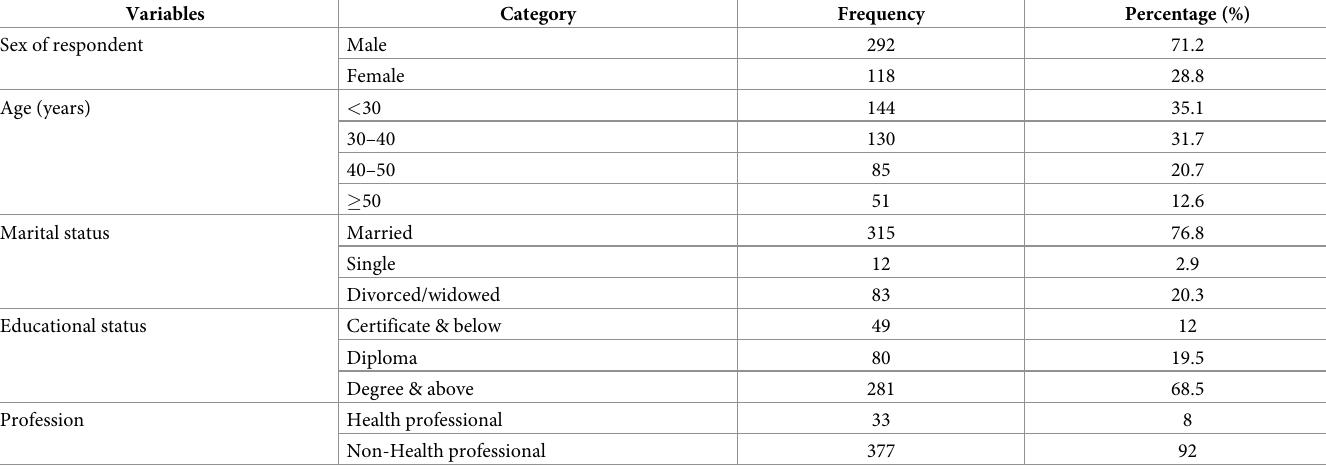
Table 1. Socio-demographic characteristics of the governmental employees in East Guji Zone, Southern Ethiopia, 2021. Variables